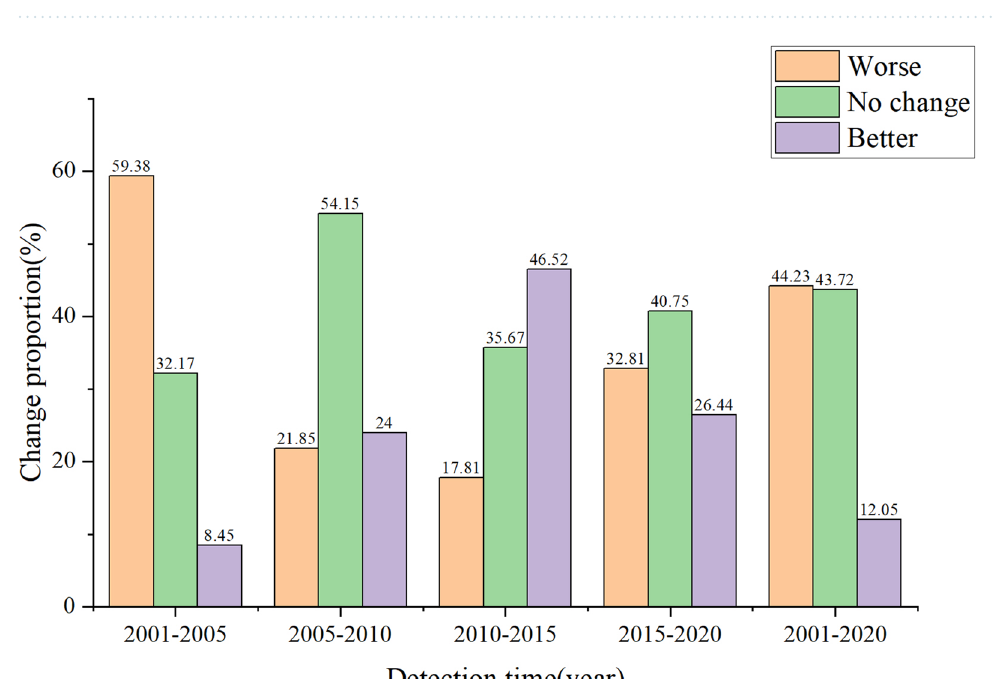
Figure 5. Change detection diagram of RSEI in northern Anhui.